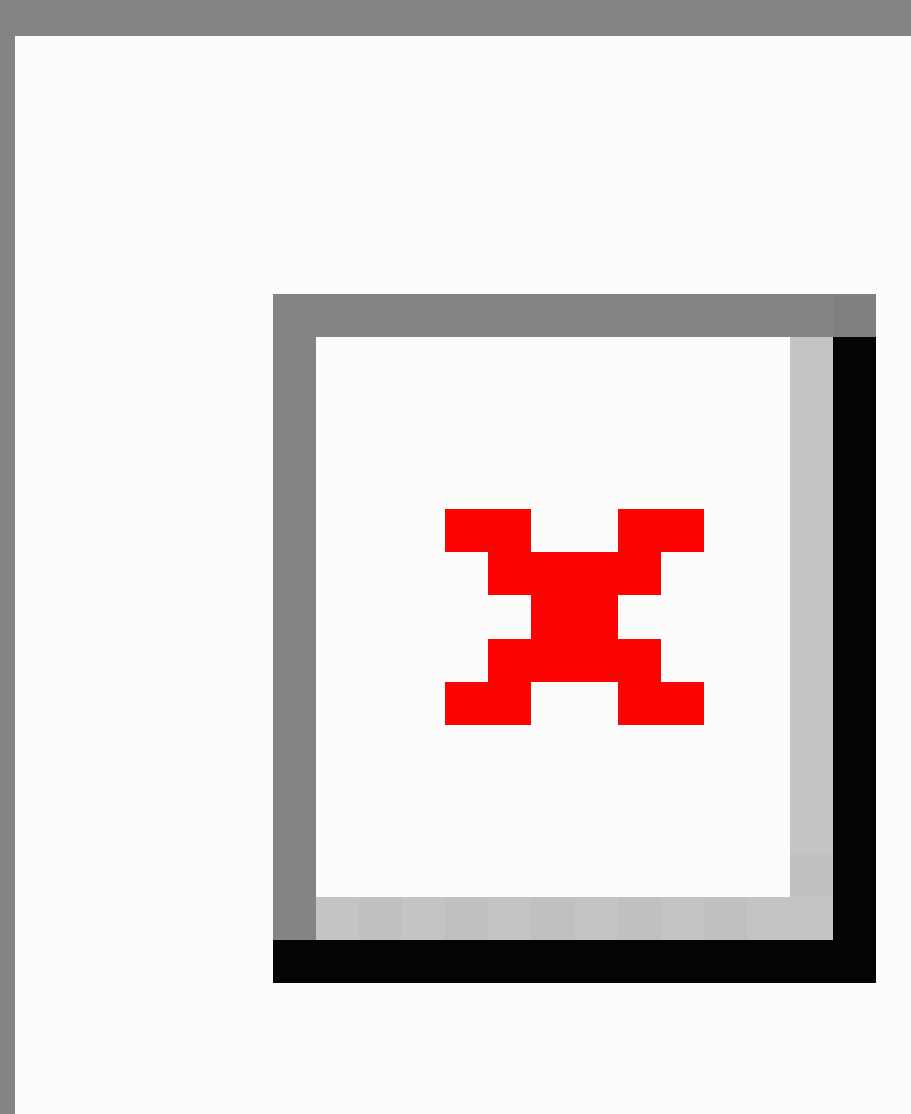
Figure 2. User perceptions of the eHealth program (n =